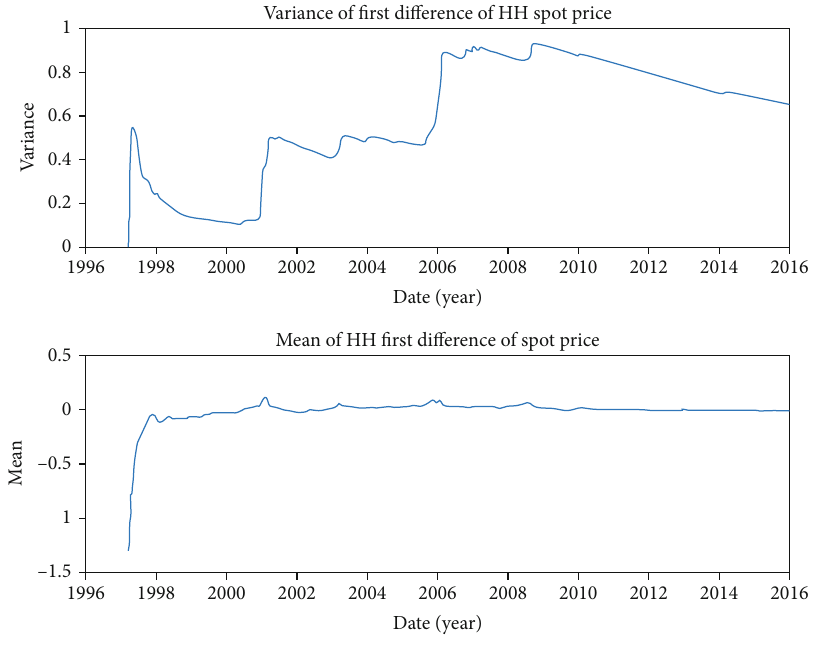
Figure 6: Mean and variance of